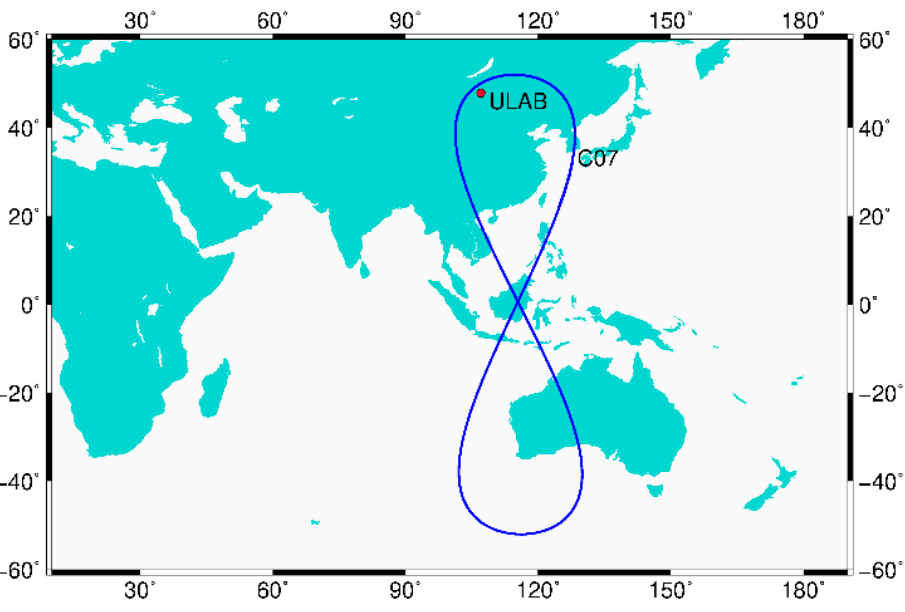
Figure 9. Station distribution and ground track of C07 satellite.